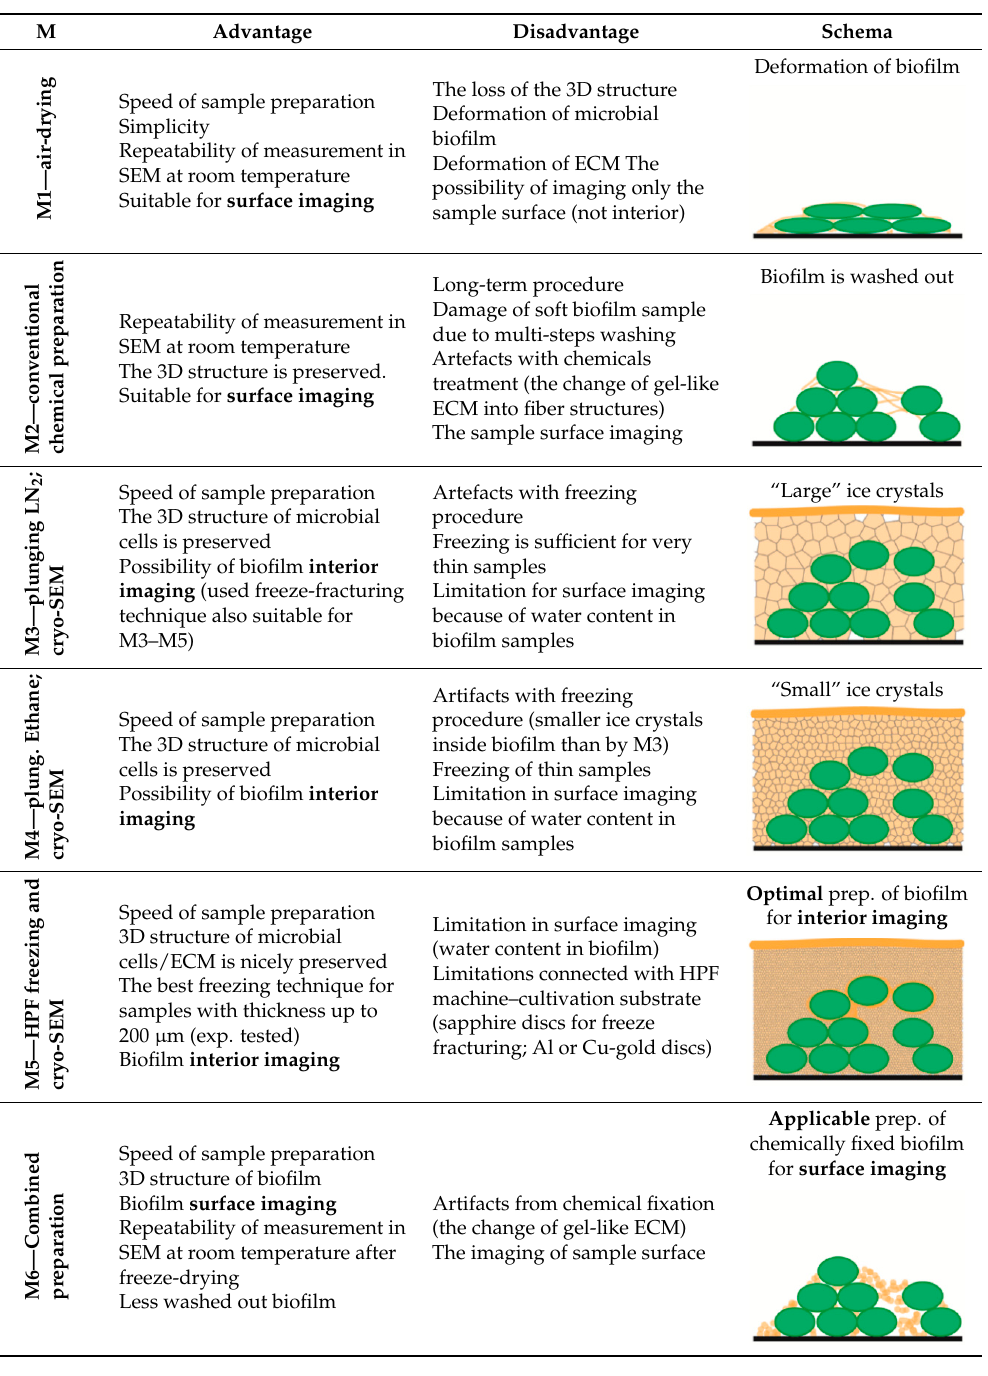
Table 1. Comparison of benefits and limitations of sample preparation protocols for SEM (Methods M1–M6) and their influence on biofilm structure as shown in schematic drawings. Our best candidates for sample preparation techniques are labelled green.